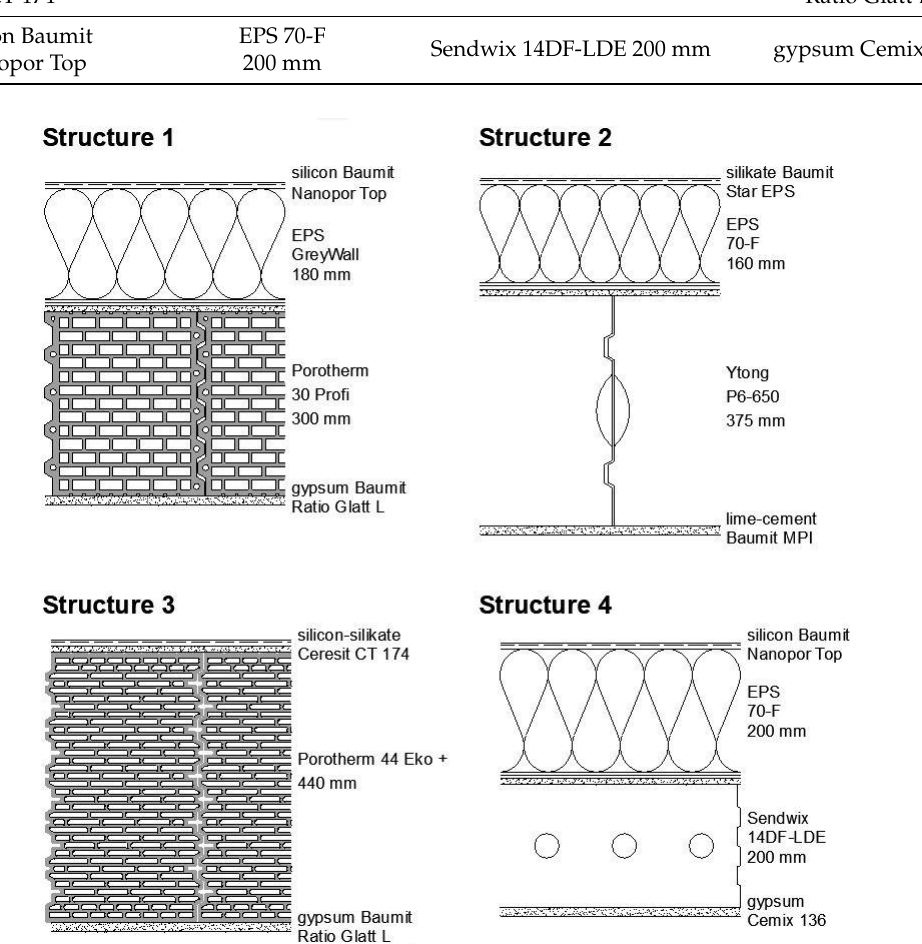
Figure 6. Structures according to Table 2.